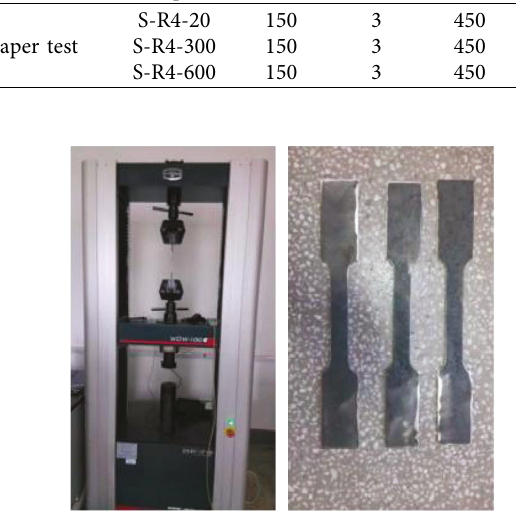
Figure 1: Testing machine and standard